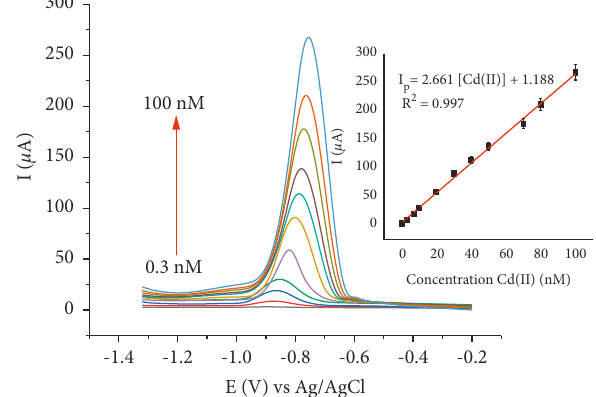
Figure 14: SWASVs of various concentrations (bottom to top: 0.3, 3, 7, 10, 20, 30, 40, 50, 70, 80, and 100 nM) of Cd(II). Inset: cal- ibration plot of peak currents versus Cd(II) concentrations. Buffer: Britton Robinson (B-R) (0.1 M, pH 4); accumulation potential: − 1.0V; accumulation time: 270s; frequency: 80Hz; pulse ampli- tude: 100mV; and step potential: